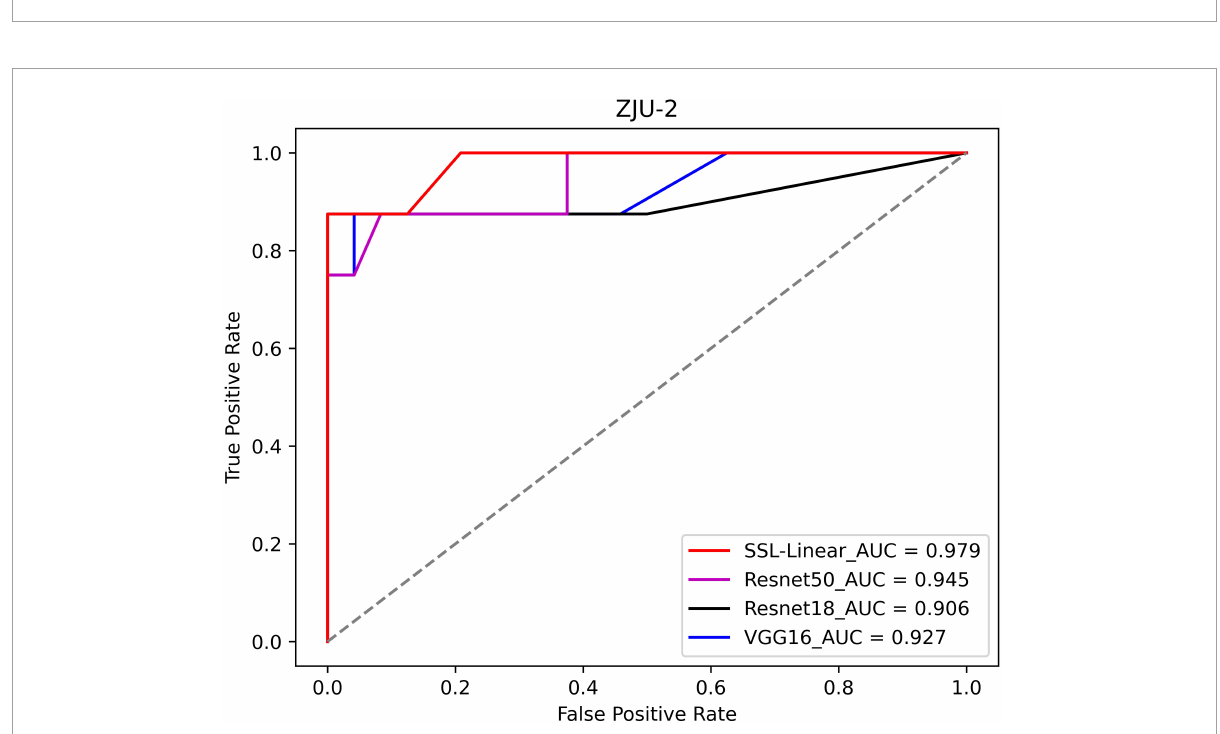
FIGURE4 The receiver operating characteristic (ROC) curves of SSL-linear and 5 CNNs. Performance of SSL-linear, VGG16, ResNet18, and ResNet50 for melanoma detection for WSIs from ZJU-2. AUC, the area under the receiver operating characteristic curve; ZJU-2, The Second